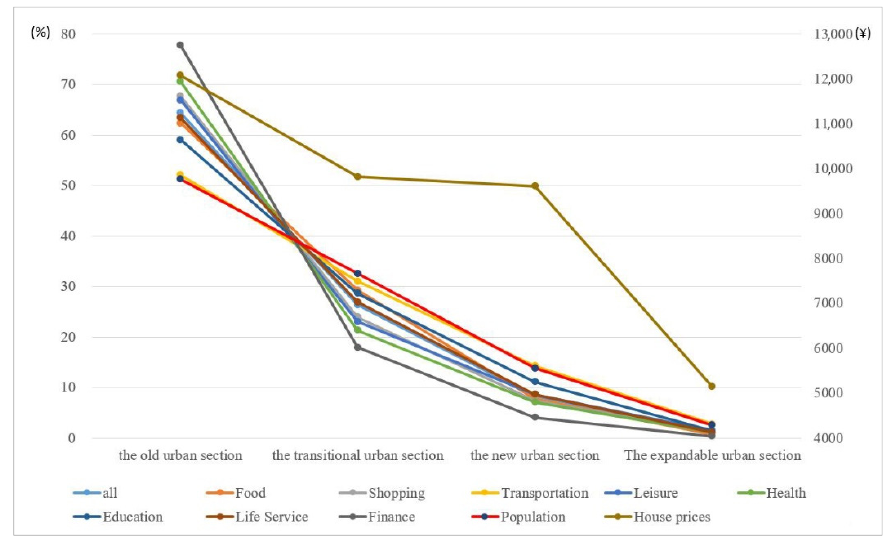
Figure 7. Quantitative proportion of supply and demand components in various urban sections.